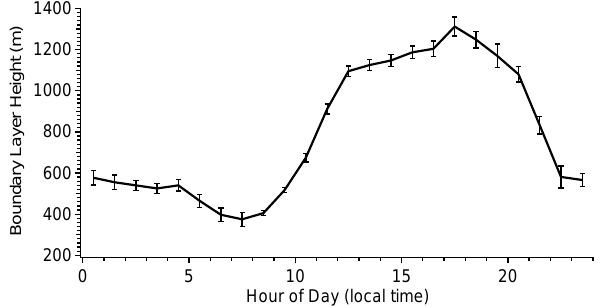
Figure 14. Diurnal variation of boundary layer height for CTR_June. The solid line indicates the median concentration and the error bars indicate the standard